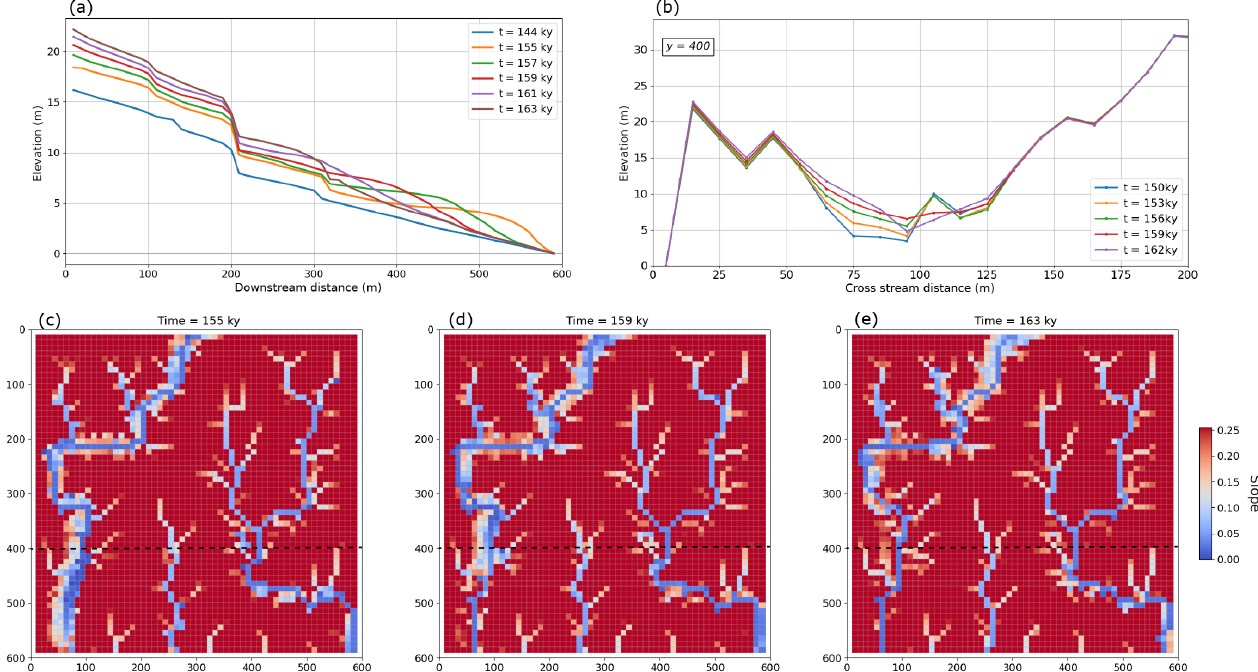
Figure 10. Longitudinal profile, cross sections, and slope maps from model run TB1.5, with medium K after cessation of increased water flux. (a) Longitudinal channel profiles show uplift and aggradation, which produces a convexity that propagates upstream. (b) Cross sections across the model domain at y = 400 show channel aggradation and new lateral erosion of valley walls. (c, d, e) Slope maps show valley narrowing following the passage of the knickpoint where y = 400 (dashed line) at 155, 159, and